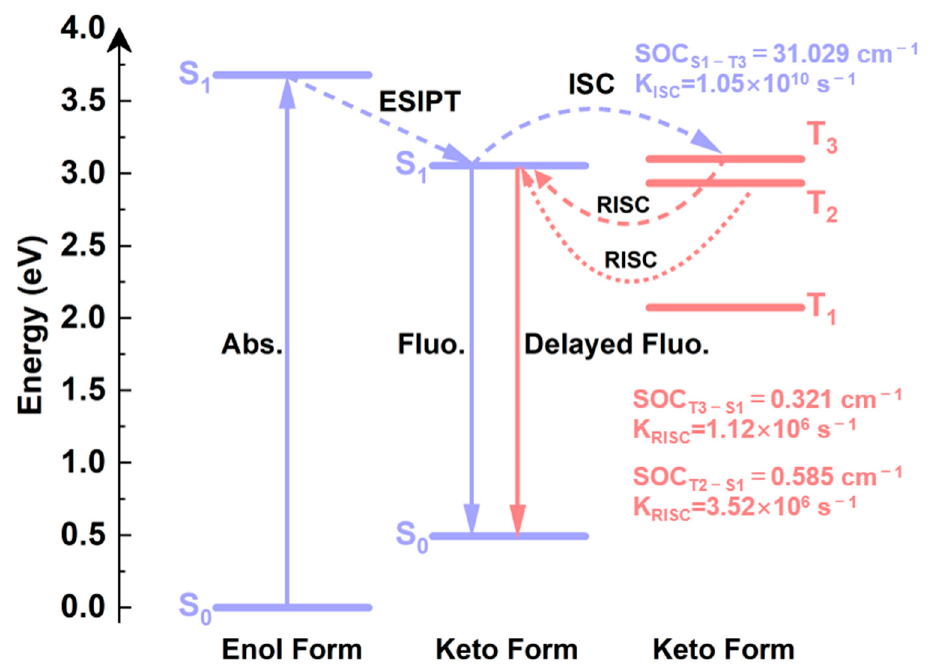
Figure 8. The schematic diagram of photoluminescence processes for BP(OH) 2 in hexane solvent.